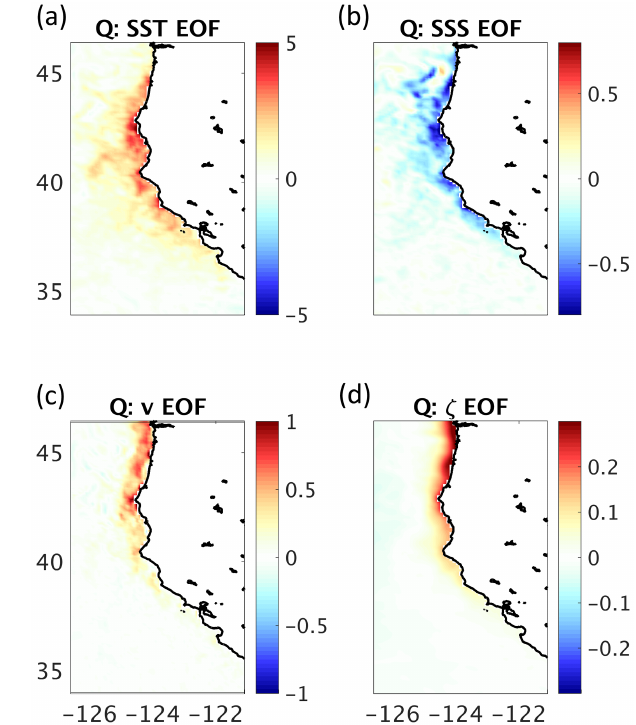
Figure 7. The structure of the leading EOF of ˆ Q (computed using unsmoothed δ x ) for surface (a) temperature, (b) salinity, (c) merid- ional velocity, and (d) sea surface